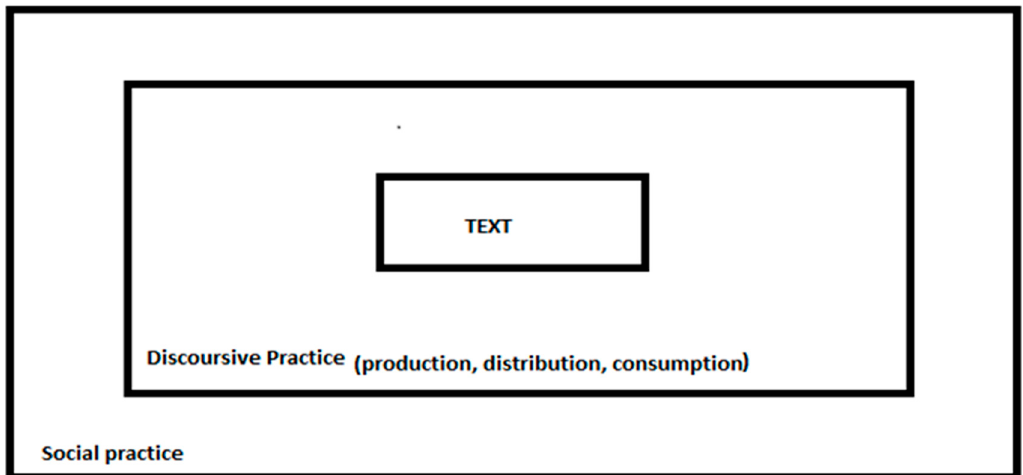
Figure 1. Discourse and social change by Fairclough.